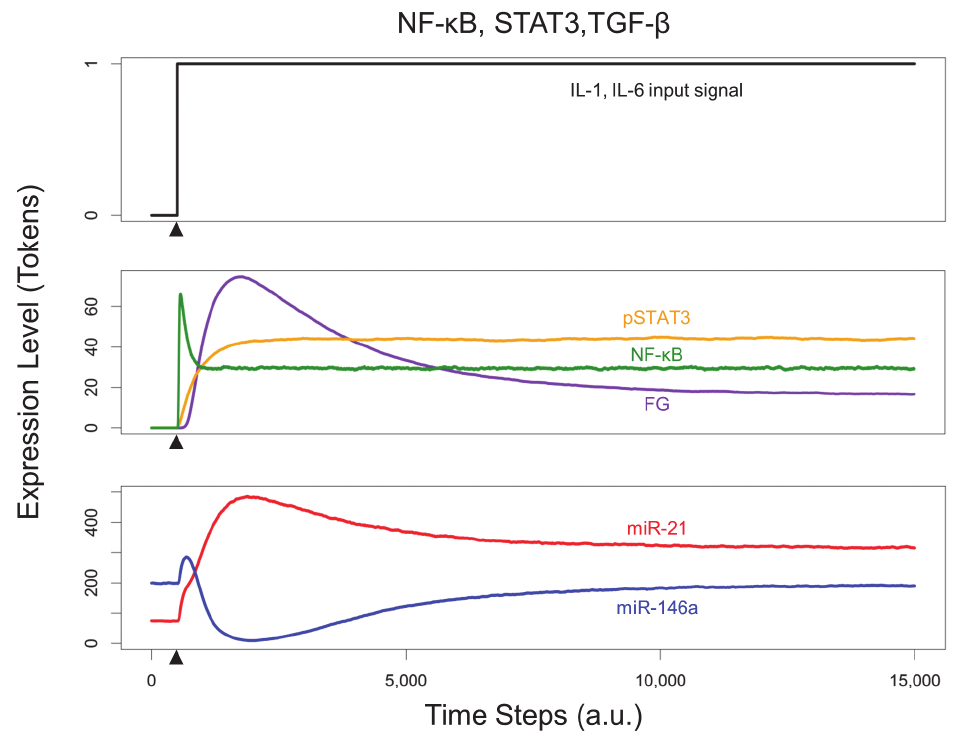
Figure 5. Dynamics of microRNA and transcription factor expression levels of the integrated model with all three signaling